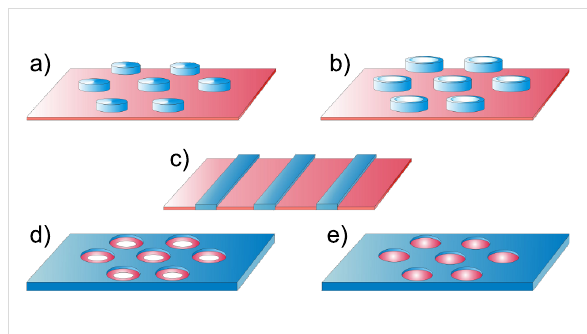
Figure 4: Schematic representation of some of the possible nanostruc- tures formed by binary combs with strongly adsorbed A side chains (red) and partially desorbed B chains (blue): (a) Disc-shaped micelles ordered with the symmetry of a hexagonal lattice (HEX); (b) Torus- shaped micelles ordered with HEX symmetry; (c) parallel stripes; (d) Inverse torus-shaped micelles ordered with HEX symmetry; (e) inverse disc-shaped micelles (“holes”) also ordered with HEX